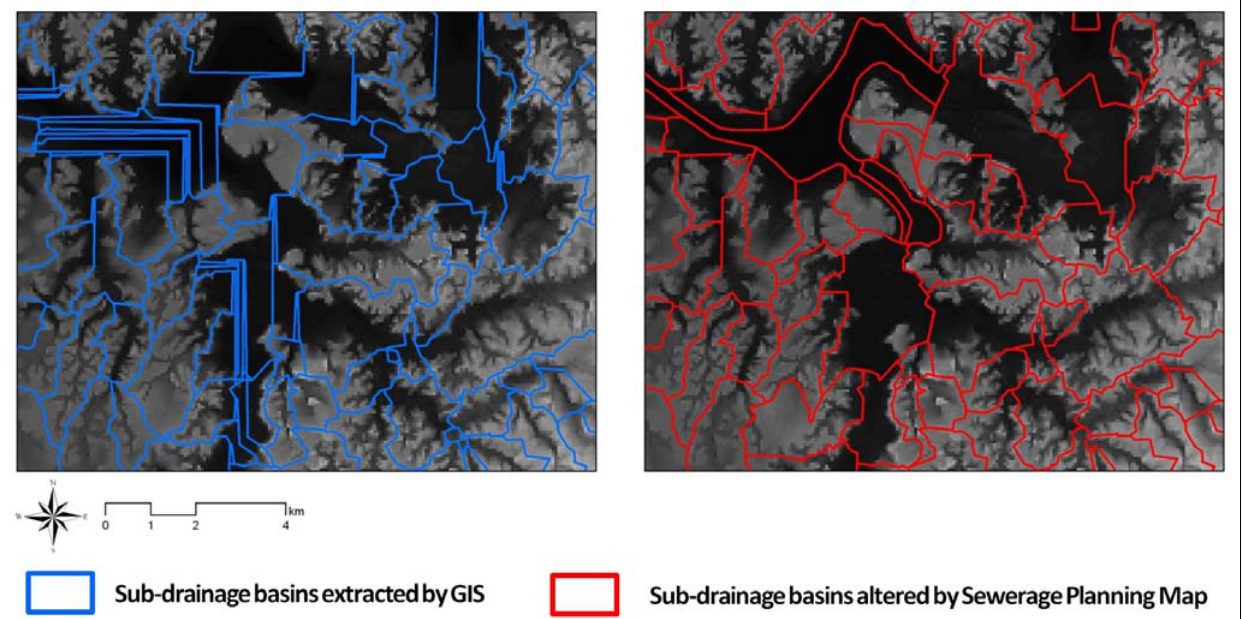
Figure 5. Maps showing sub-drainage basins extracted by Geographic Information Systems (left) and altered with drainage plan maps